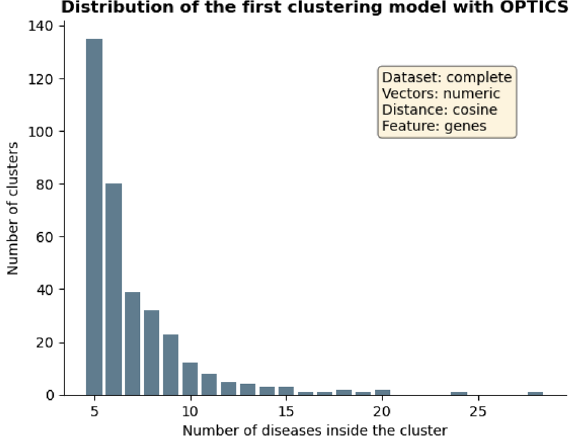
Figure 1. Distribution of the number of diseases in each cluster for the first analysed model obtained performing OPTICS. The model was generated from the complete dataset regarding genes as the studied features, with numeric vectors and computing distances with cosine metric. The histogram bars were filtered so that clusters with less than 5 diseases are not displayed. The global results for this model were of 2199 clusters, 3032 diseases as noise (from a total of 10,300), a Silhouette score value of 0.46, a CH score value of 10.9 and DB score value of